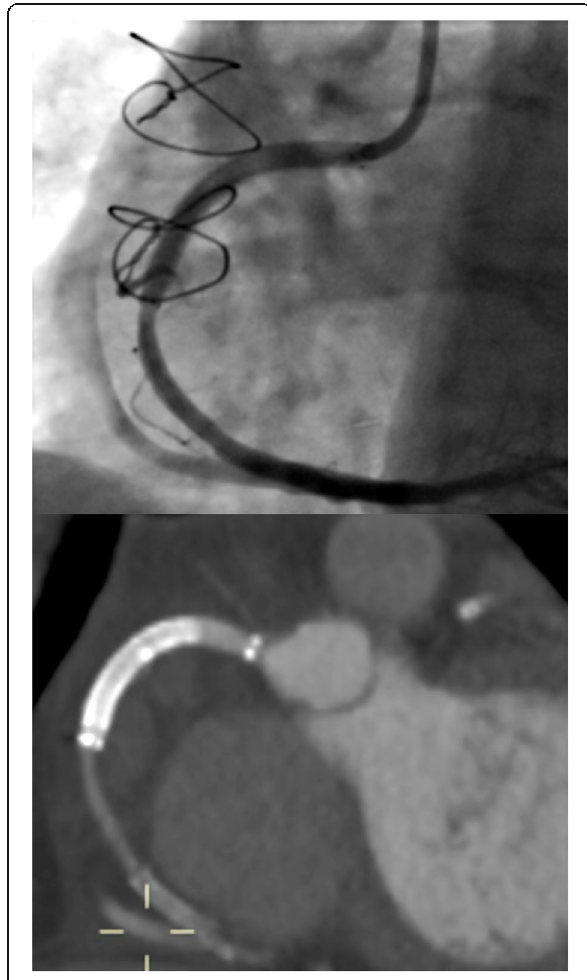
Fig. 3 AP projection and CT coronary angiogram showing the Viabahn stent graft in situ with distal patency (reflux of contrast seen into the right